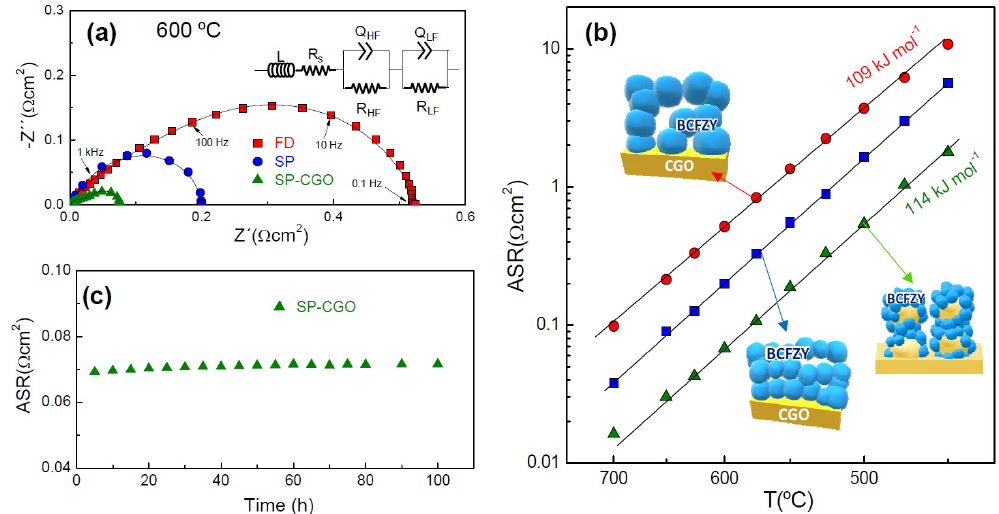
Figure 3. ( a ) Impedance spectra of the symmetrical cells and the equivalent circuit used to simulate the data. ( b ) Polarization resistance as a function of the temperature. ( c ) ASR over time at 600 ° C.